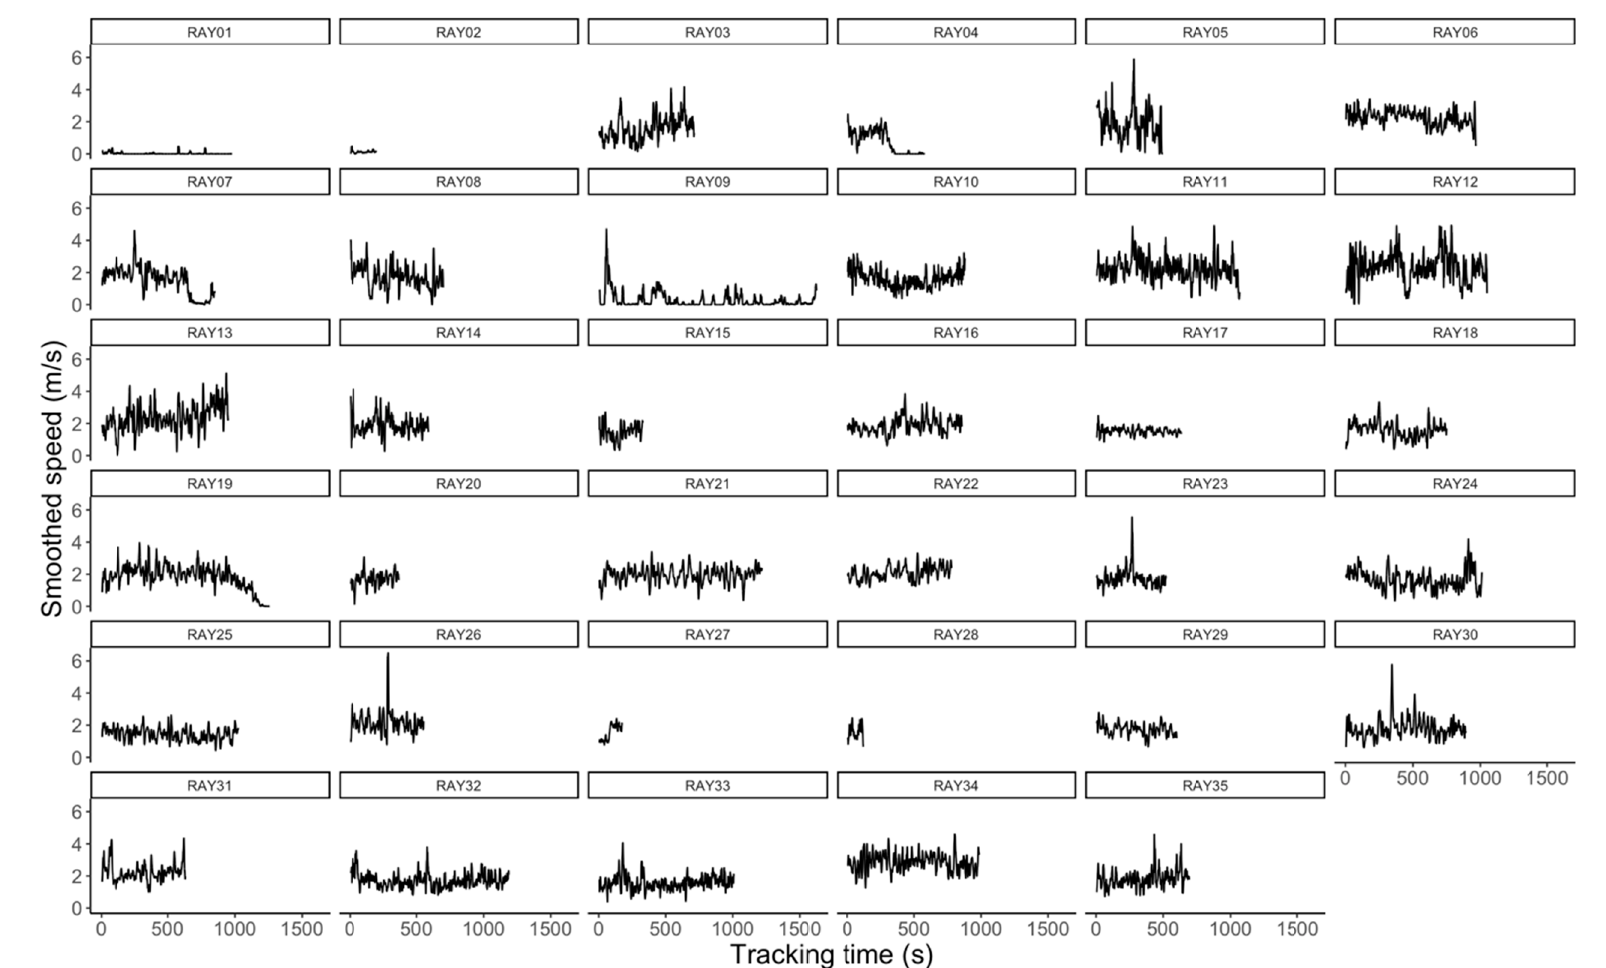
Figure 6. Speed profiles of each ray track. Smoothed speed refers to a rolling mean of the speed across ten-second